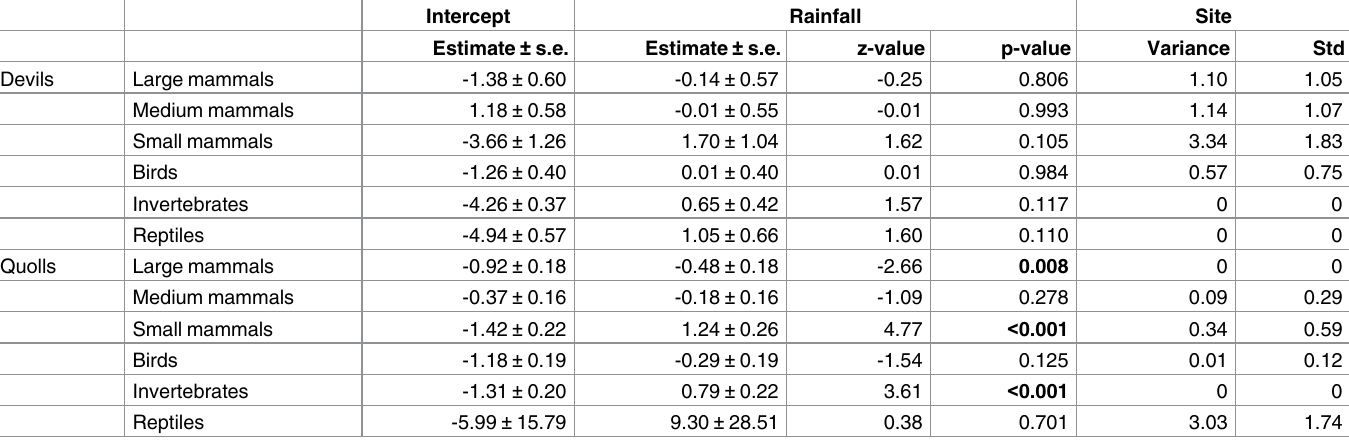
Table 5. Generalised linear mixed model (GLMM) estimatesand standard errors for the effect of rainfall on diet composition of devils and quolls for each prey category. Site was includedas a random factor. Bold numbers indicatestatistical significant( p value <